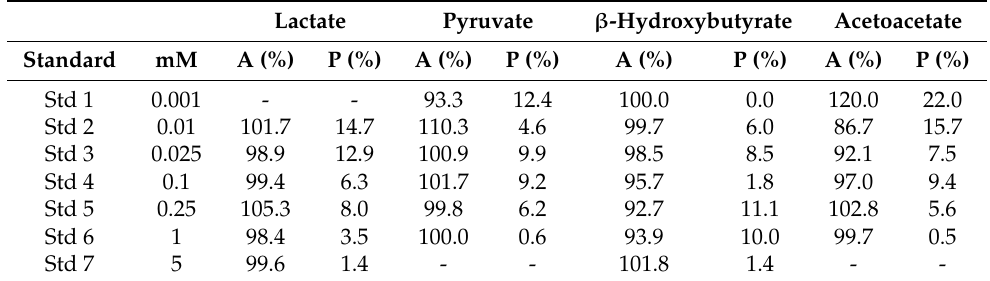
Table 2. Precision and accuracy values of the calibration curve standards ( n = 3). A: accuracy; P: precision; Std: